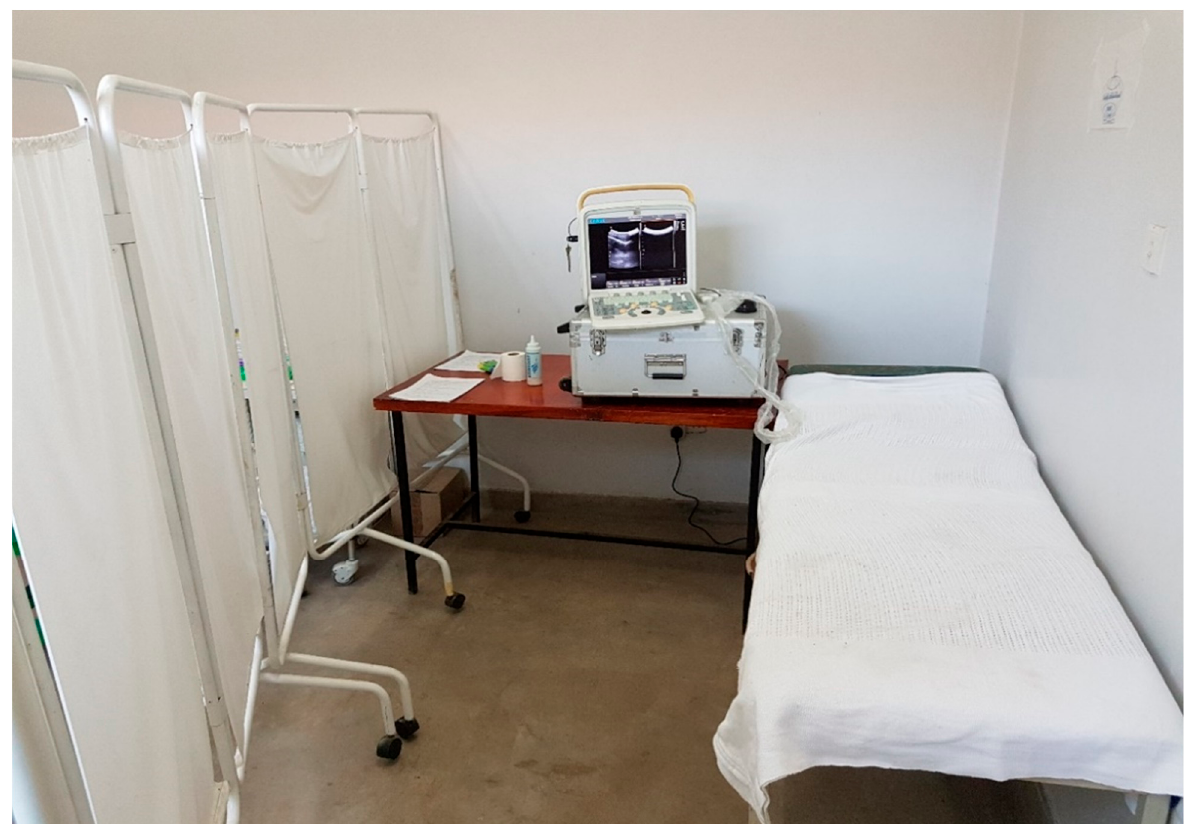
Figure 2. The portable Chison Q5 ultrasound scanner in an examination room.